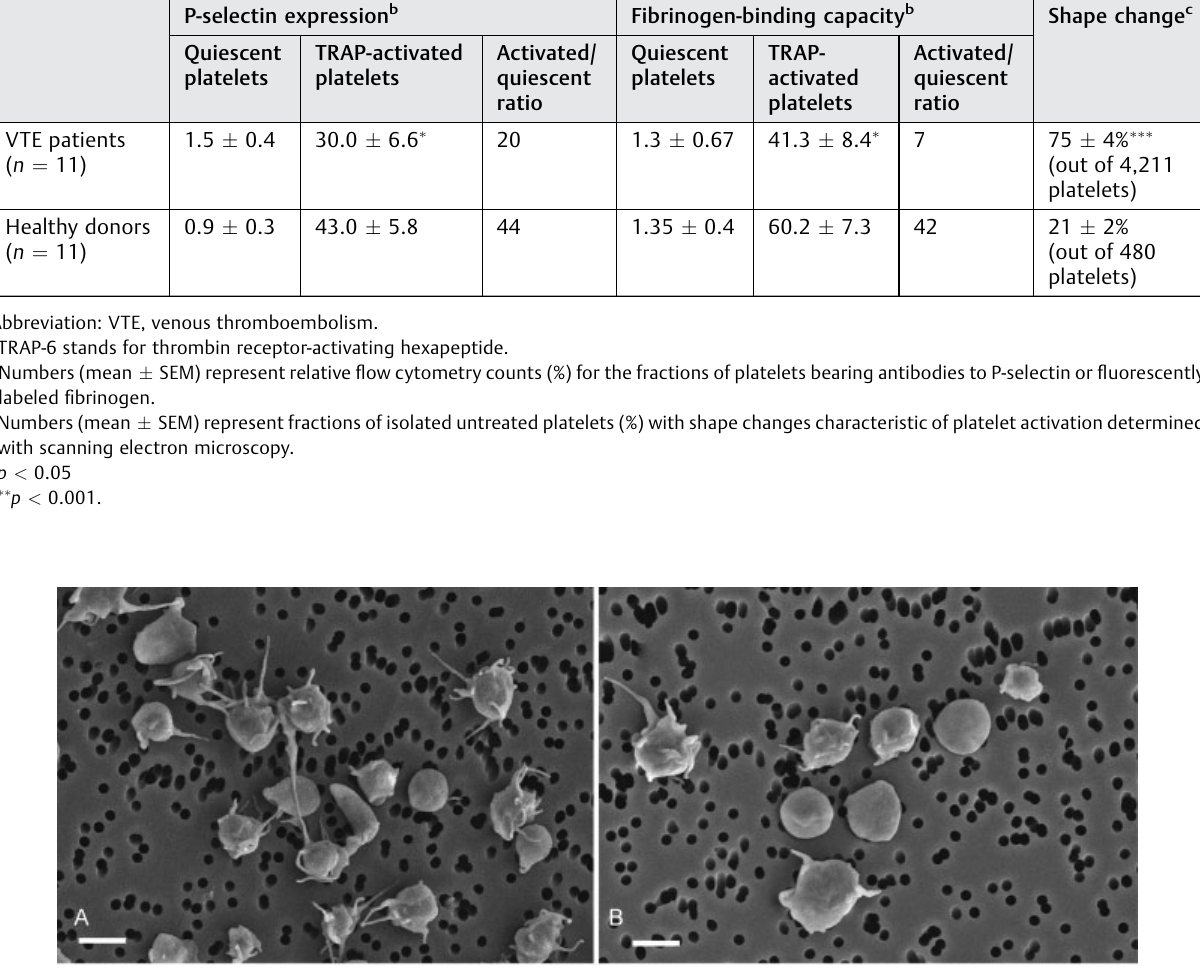
Fig. 5 Representative scanning electron micrographs of unstimulated platelets isolated from the blood of a VTE patient ( A ) and a healthy donor ( B ), showing a higher degree of partial activation of the unstimulated (quiescent) platelets in VTE re fl ected by the shape change, formation of fi lopodia, and tendency to aggregate. Magni fi cation bars ¼ 2 µm.